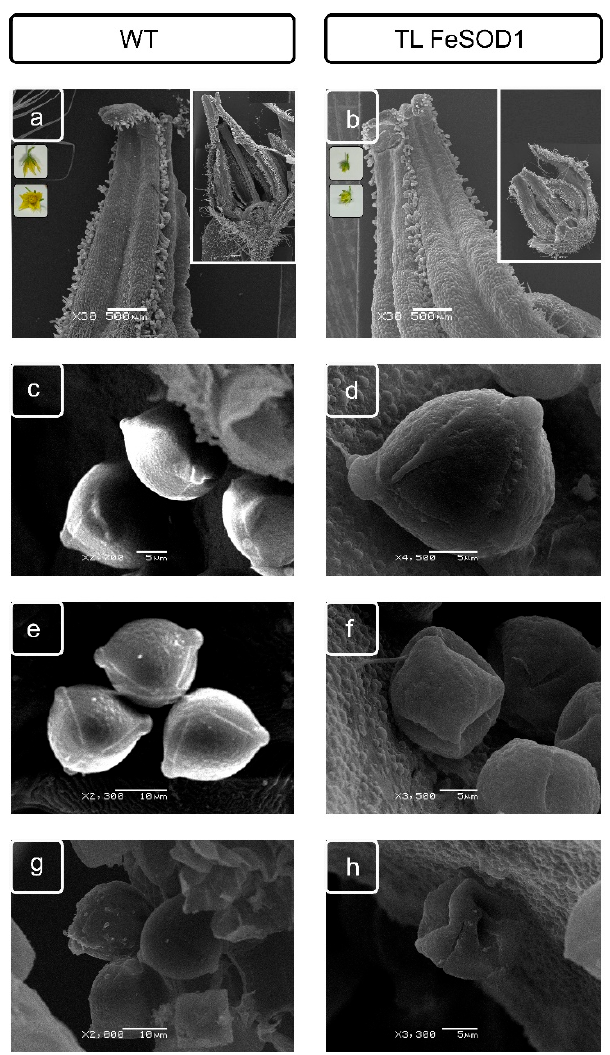
Figure 1. Transmission scanning microscopy of flowers ( a , b, inserts), formed anthers ( a , b ), and pollen (general appearance—( c , d ); exine and germpore of pollen grain—( e–h ) from WT ( a , c , e , g ) and transgenic ( b , d , f , h ) tomato lines.